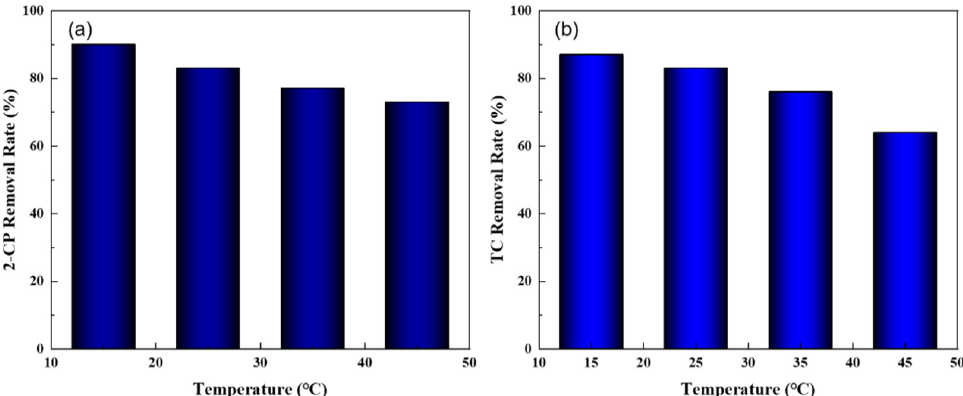
Figure 8. ( a ) Effect of temperature on the degradation in organic pollutant 2-CP ( b ) Effect of temperature on the degradation in organic pollutant TC.